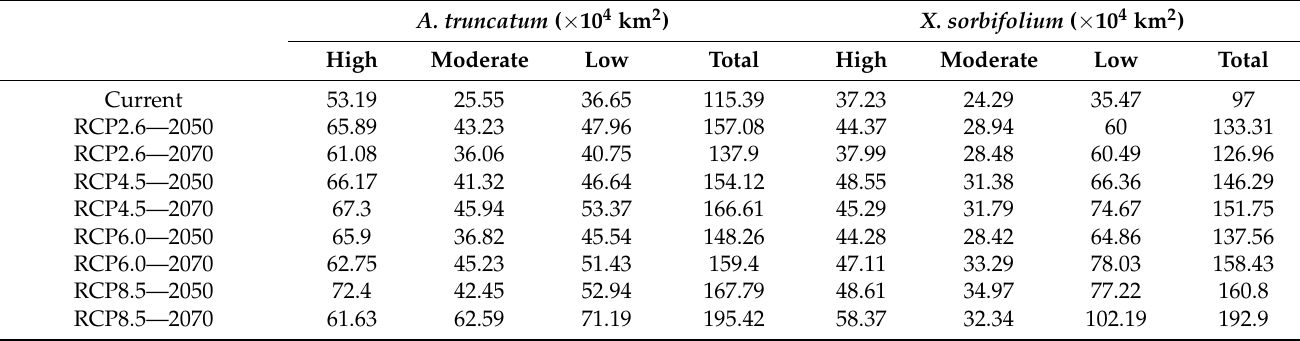
Table 2. Potential suitable areas of different grades of A. truncatum and X. sorbifolium under current and future four climate scenarios (2050s and